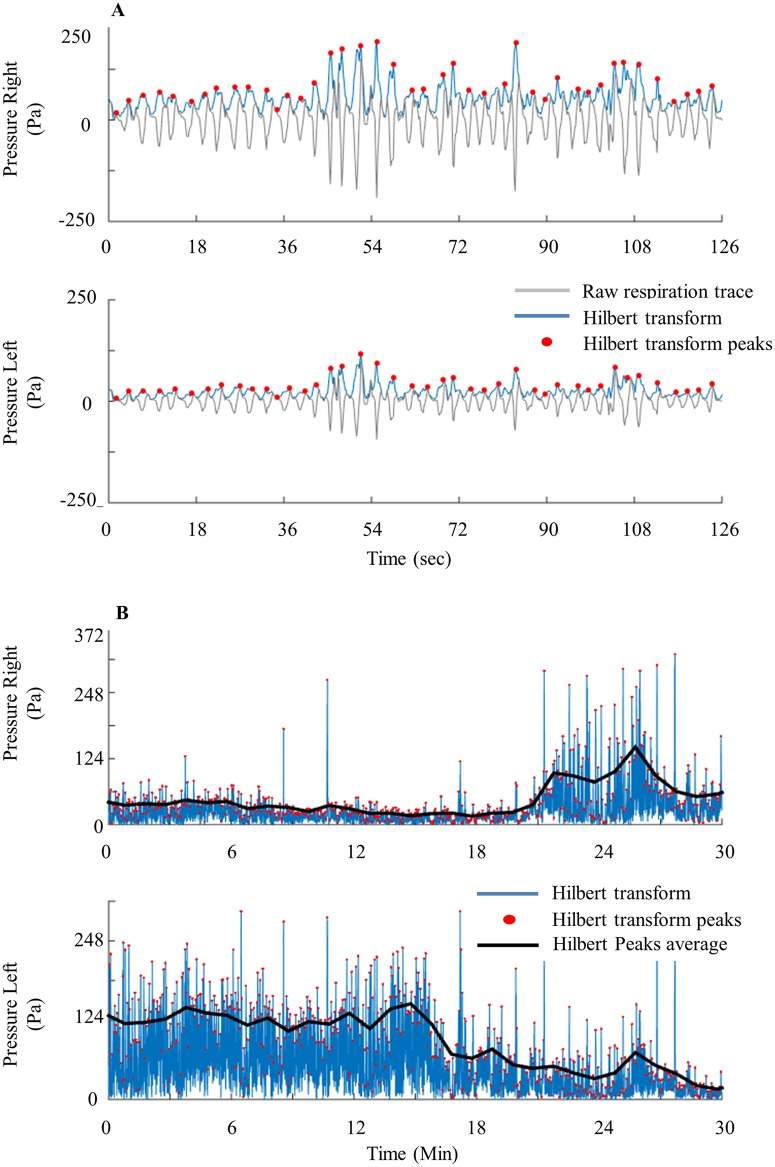
Pre-processing stages.(A) Raw data overlaid with Hilbert transform and its peaks during 2 minute time scales. (B) Hilbert transform overlaid with its peaks and average during 30 minute time scales.